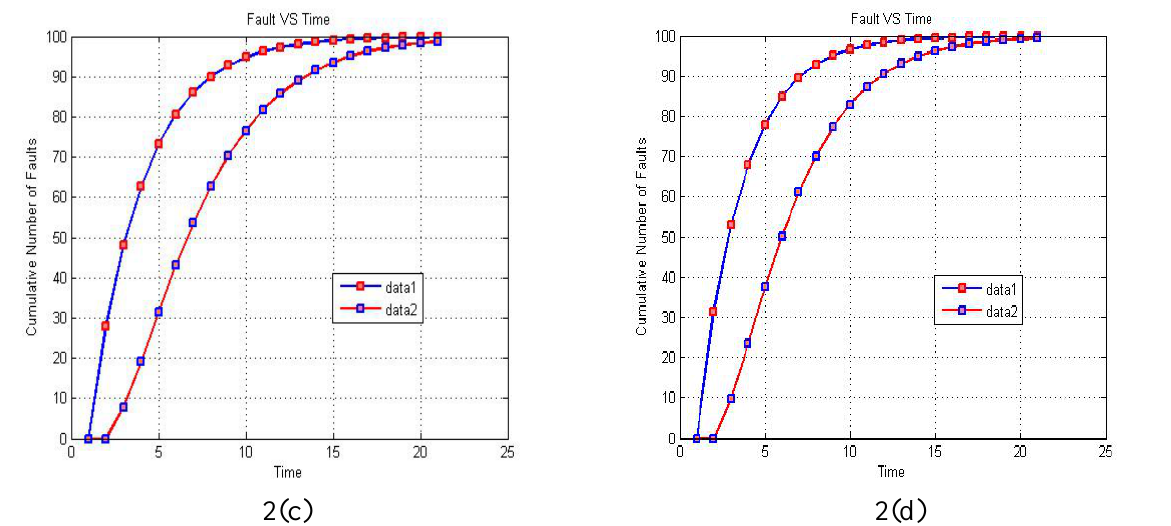
Fig. 2 . Number of detected and corrected faults vs. Time (a)